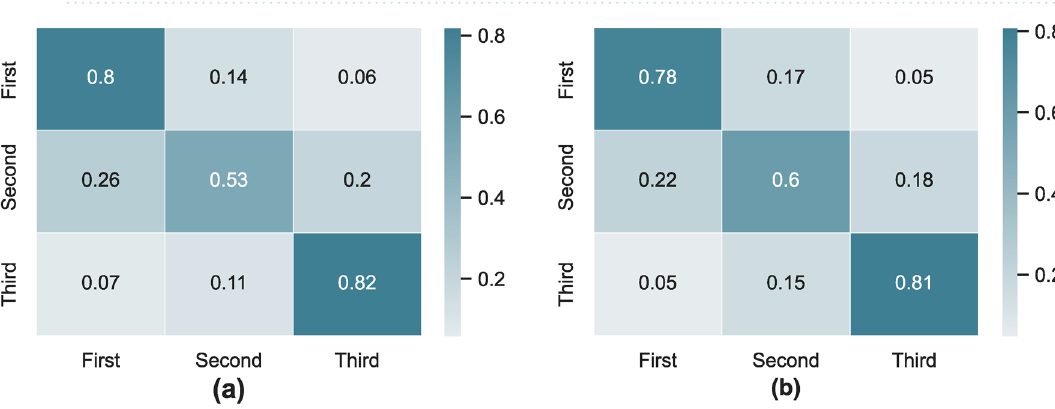
Figure 7. Confusion matrix of the ( a ) random forest ( b ) LightGBM classification models which is trained to predict the blood creatinine level in three classes. Each row indicates the ratio of a samples in a certain class (row label class) that are classified in different classes (column label